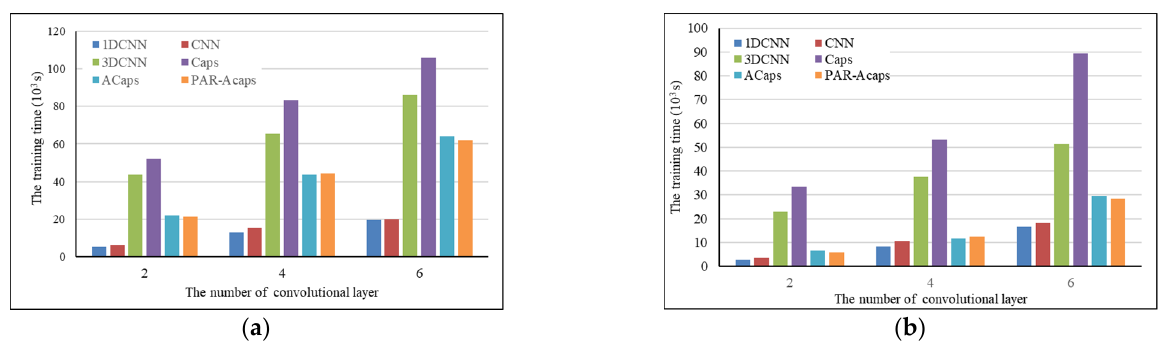
Figure 13. The training time of 1DCNN, CNN, 3DCNN, Caps, ACaps, and PAR-ACaps with a different number of convolutional layers (two, four, and six). ( a ) The training time for PU dataset and ( b ) the training time for SA dataset.